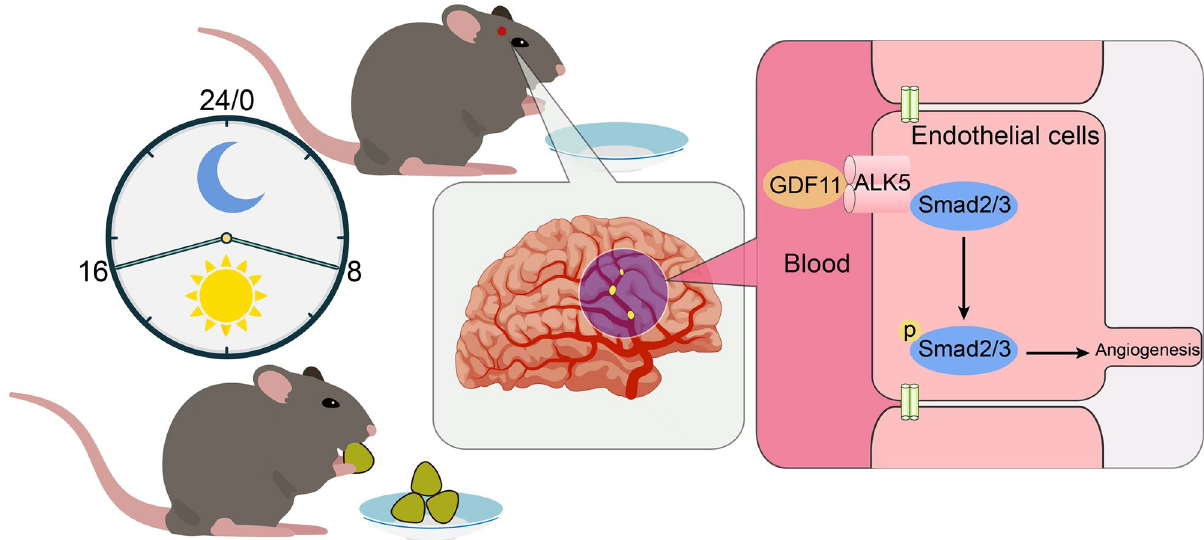
Fig 6. Schematic diagram of IF on cerebral angiogenesis hypothesis. Long-term IF promotes metabolism and energy conversion, and activates GDF11/ALK5 signaling pathway in blood circulation. Accompanied by phosphorylation of downstream signaling Smad2/3, cerebral angiogenesis is further activated. The promotion of neurological recovery induced by IF in ischemic stroke is partly mediated by its angiogenic effects.